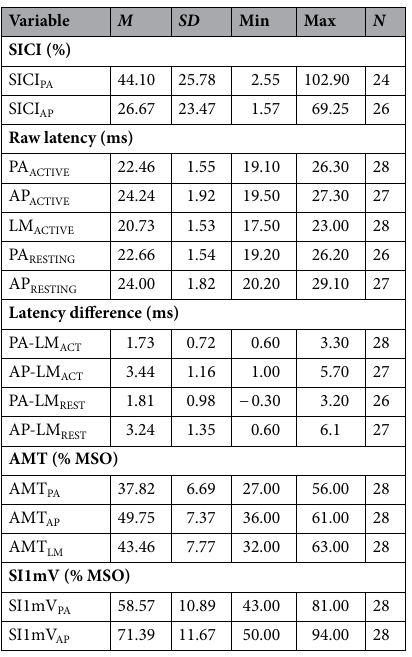
Table 1. Descriptive statistics. SICI % Short-Interval Intracortical Inhibition, 100% no inhibition, < 100% inhibition, PA posterior–anterior, AP anterior–posterior, LM latero-medial; Raw Latency, ms, latencies in indicated condition; Latency Difference, ms, difference from LM latency; AMT, active motor threshold; SI1mV, stimulus intensity 1 mV; MSO, maximal stimulator output (MSO).